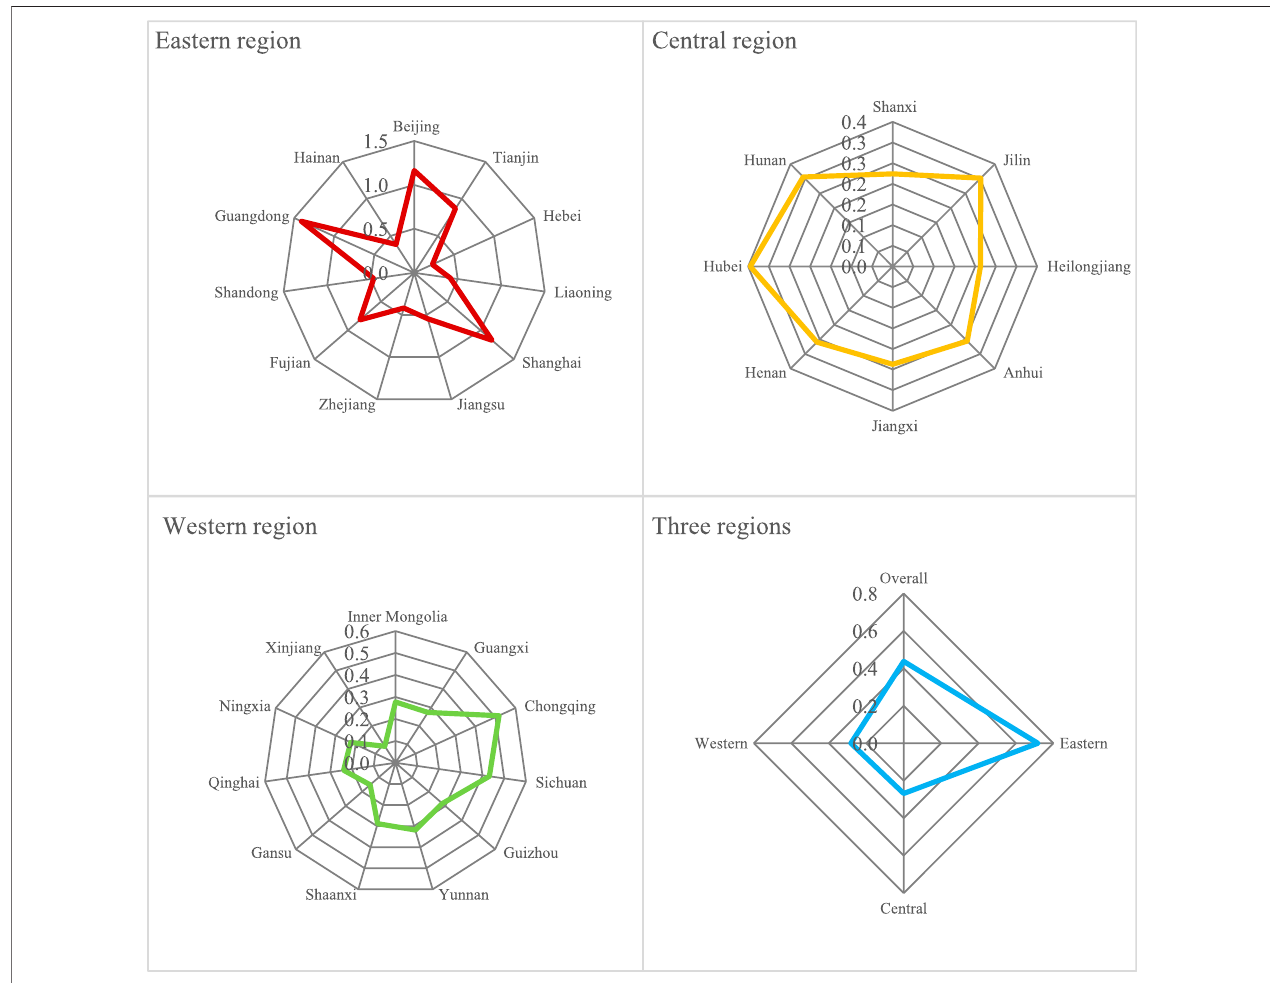
FIGURE 2 | Comparison of the average environmental ef fi ciency in China ’ s three